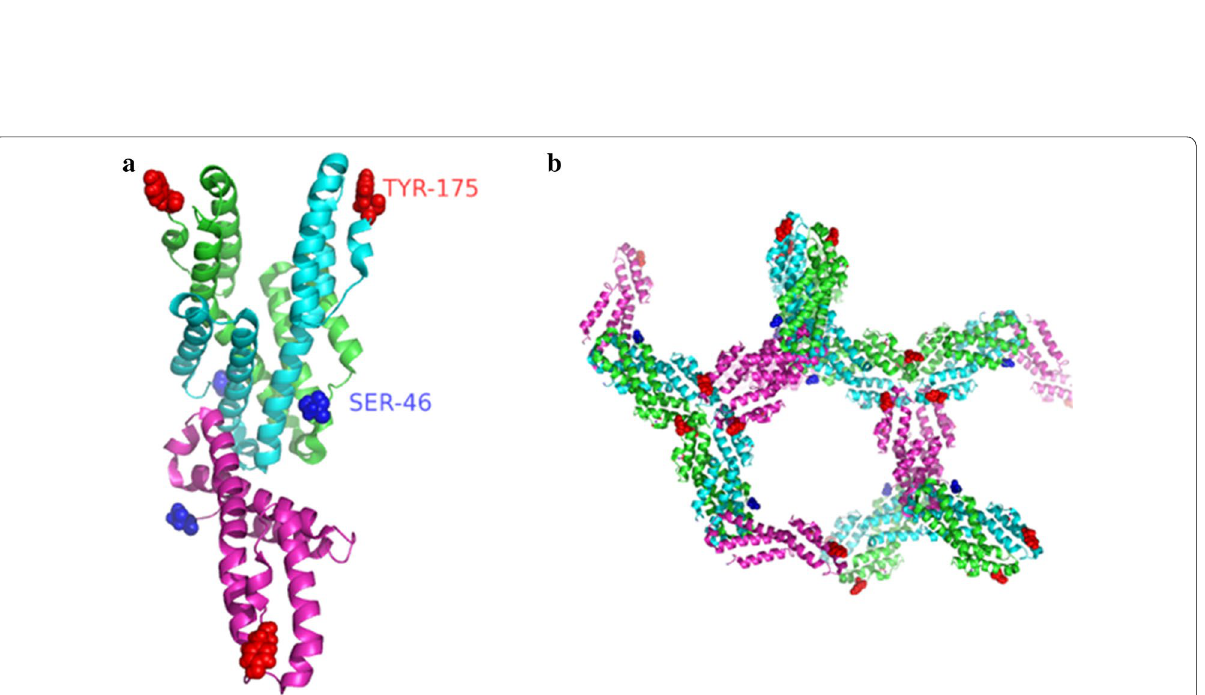
Fig. 5 Structure of CelTOS (PDB 5TSZ) from P. vivax. a Three molecules (green, cyan and magenta) are found in the unit cell. b Crystal packing is shown. The first and the last ordered residues are Ser-46 (blue spheres) and Tyr-175 (red spheres). The structure is predominantly